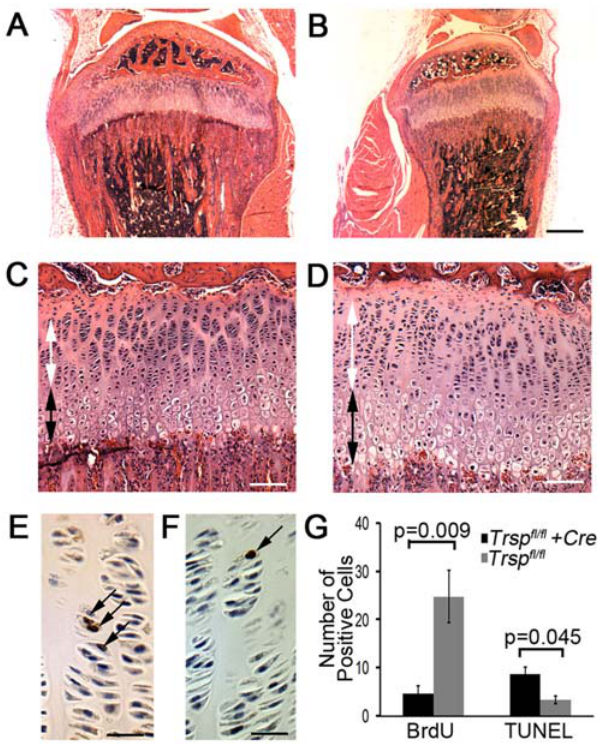
Figure 3. Tibial epiphyseal growth plate abnormalities in Trsp fl/fl Col2a1-Cre mice. Relative sizes and morphological differences between the tibiae of (A) Trsp fl/fl (control), and (B) Trsp fl/fl Col2a1-Cre mice (hematoxylin and eosin stained sections) are shown. Note smaller bone size, and the disproportionate widening of the epiphyseal growth plate in the Trsp fl/fl Col2a1-Cre mice. Higher magnification views of representative growth plate sections from Trsp fl/fl (C) and Trsp fl/fl Col2a1- Cre (D) mice; there was widening of both the proliferative (white two- headed arrows) and hypertrophic (black two-headed arrows) zones in the mutant mice. BrdU + nuclear staining revealed an increase in the number of mitoses within the tibial growth plate proliferative zones of Trsp fl/fl (E) as compared to Trsp fl/fl Col2a1-Cre (F) mice (arrows indicate examples of BrdU + cells). Scale bars were as follows: 450 m m (A and B), 55 m m (C and D) and 27 m m (E and F). (G) Numbers of BrdU + nuclei (n=14 Trsp fl/fl Col2a1-Cre and n=7 Trsp fl/fl tibiae), and TUNEL positive apoptotic cells (n=3 Trsp fl/fl Col2a1-Cre and n=5 Trsp fl/fl tibiae) present in the epiphyseal growth plates. Data are shown as mean + / 2 SEM.